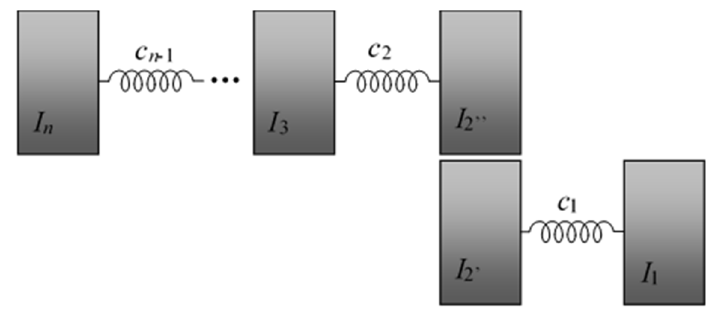
Figure 3. Model of the drive system including the first